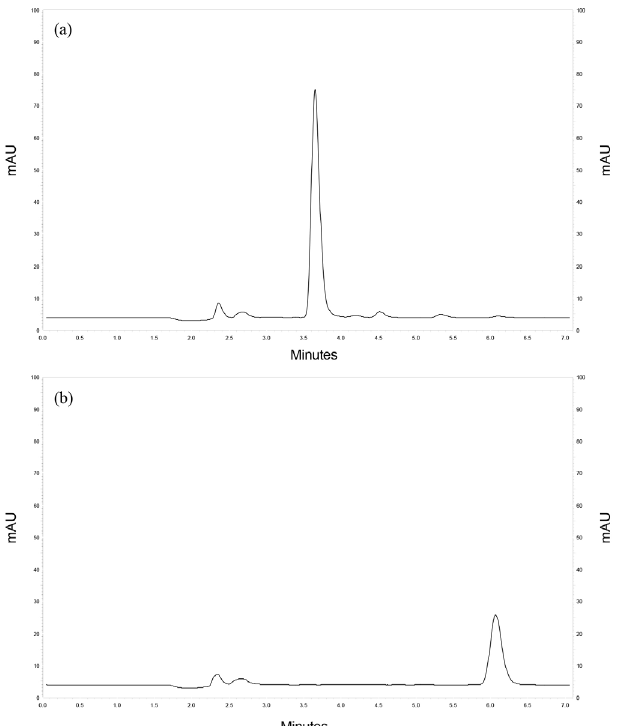
FIGURE 3 - Chromatograms obtained after one hour of BD exposure under alkaline conditions 0.1 mol/L NaOH (a) and under acid conditions 0.1 mol/L HCl (b).